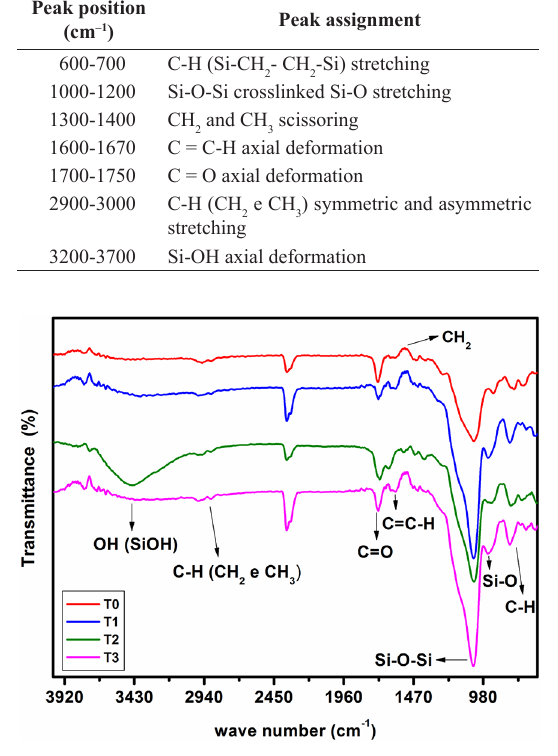
Figure 7. FT-IR spectra of the hybrid coatings.